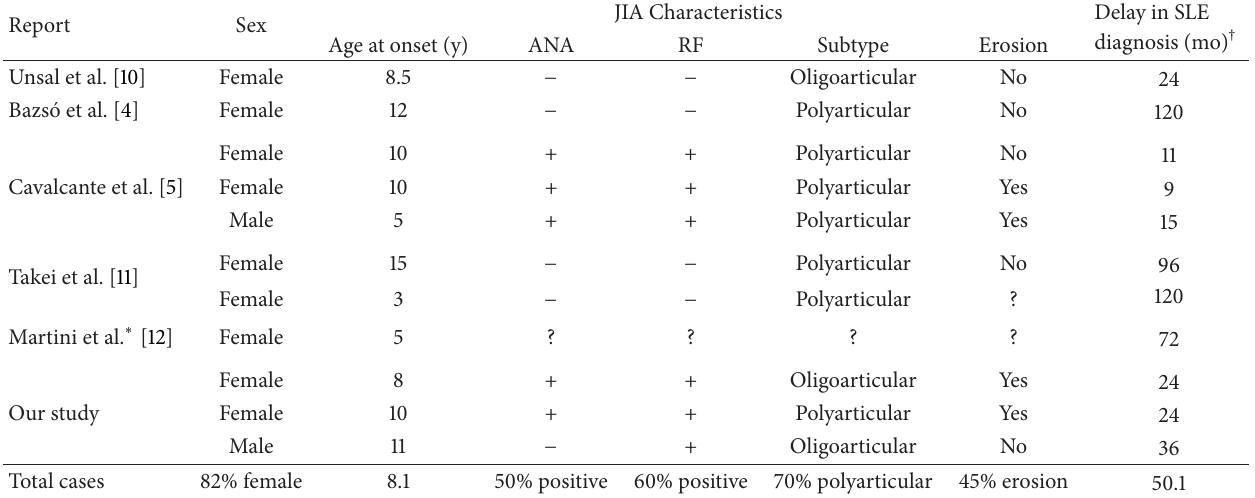
Table 1: Clinical and paraclincal features and outcome of cases with RHUPUS syndrome in this case report and previous reports in children. JIA Characteristics Delay in SLE Report Sex diagnosis (mo) † Age at onset (y) ANA RF Subtype Erosion Unsal et al. [10] Female 8.5 − − Oligoarticular No